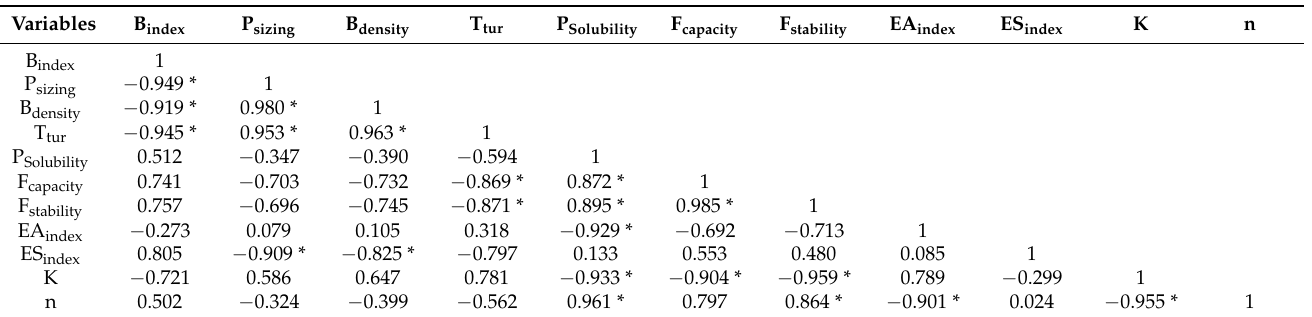
Table 4. Correlation matrix of the physical, functional and rheological parameters of freeze- and convectively-dried SP and